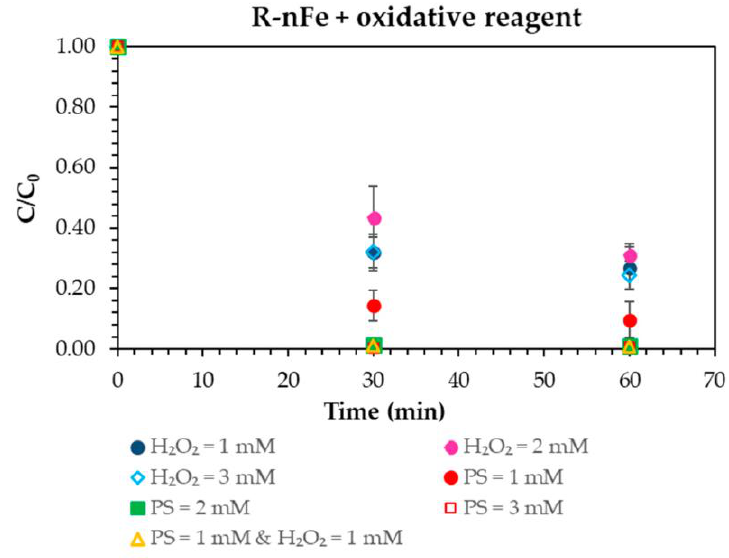
Figure 6. The synergistic effect of H 2 O 2 and PS testing at three different concentrations (1, 2, and 3 mM) with R-nFe and their combination at a concentration of 1 mM each in the removal efficiency of